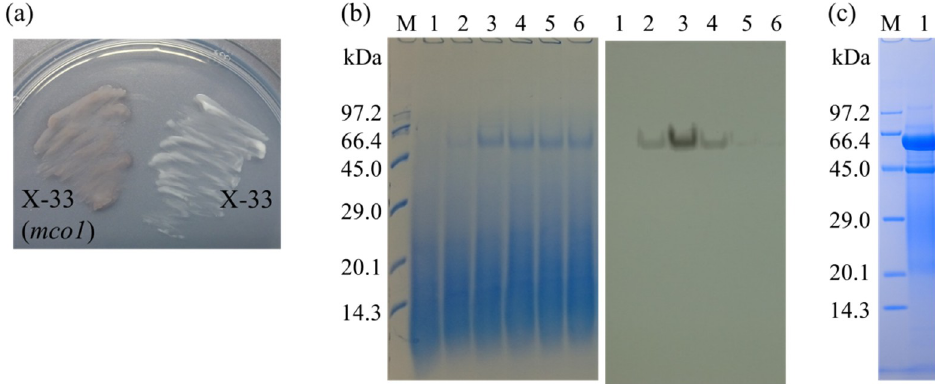
Figure 3. Expression of A. strictum KR21-2 mco1 gene in P. pastoris . ( a ) Insoluble Mn oxide production by P. pastoris X-33 transformed with pPCIZα- mco1 ( left ); ( b ) SDS-PAGE of undenatured recombinant Mco1 followed by in-gel assay of Mn(II) oxidase activity, wherein the protein bands were visualized by Coomassie brilliant blue staining ( left panel) and by formation of insoluble Mn oxides ( right panel); ( c ) SDS-PAGE of denatured recombinant Mco1 (purified by FPLC) (lane 1). Lane M was loaded with protein markers (sizes are shown on the left). Lanes 1–6 in ( b ) were loaded with the supernatant fluid from the transformant cultures collected at 0, 12, 36, 48, 60, and 72 h after induction by